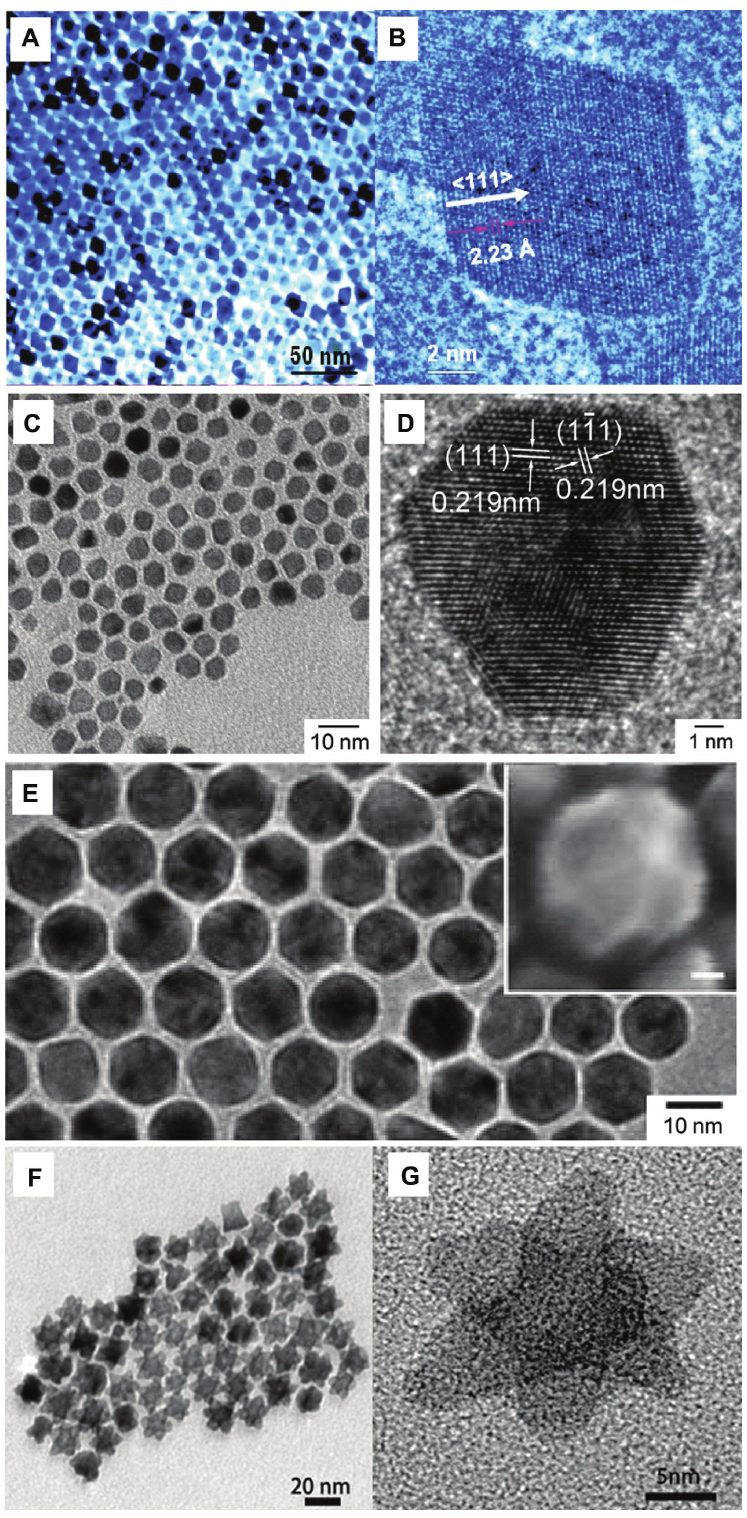
Ni octahedra. Adapted with permission from Ref. [54]. Copyright 2010 American Chemical Society. (C–D) Pt Figure 10 (A–B) Pt 3